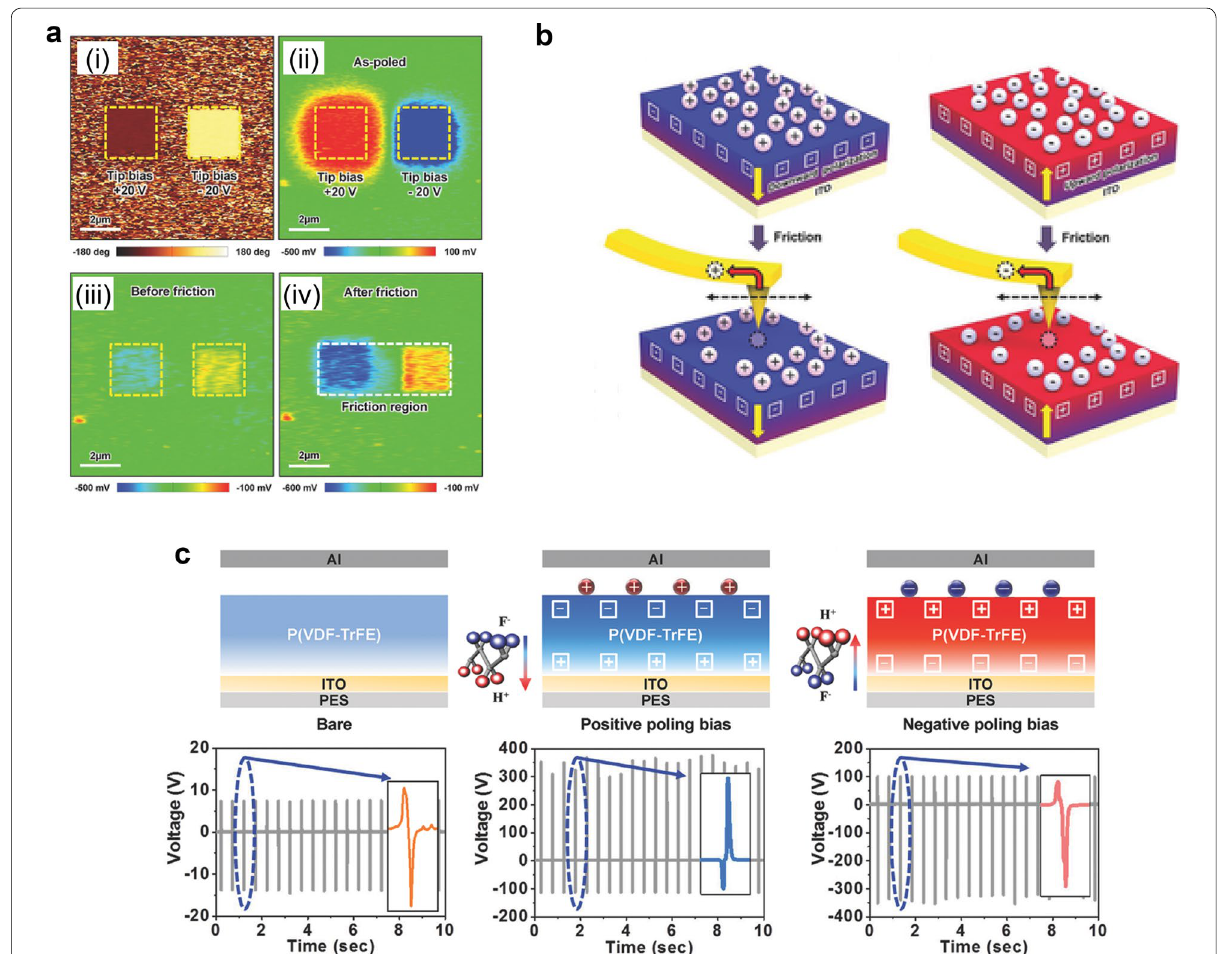
Fig. 5 a Triboelectric characteristic of P(VDF‑TrFE) after poling with opposite bias. b Charge transfer from P(VDF‑TrFE) surface by rubbing AFM tip. c Controlling triboelectric output voltage of P(VDF‑TrFE) with different ferroelectric polarizations (Reproduced from [42] with copyright